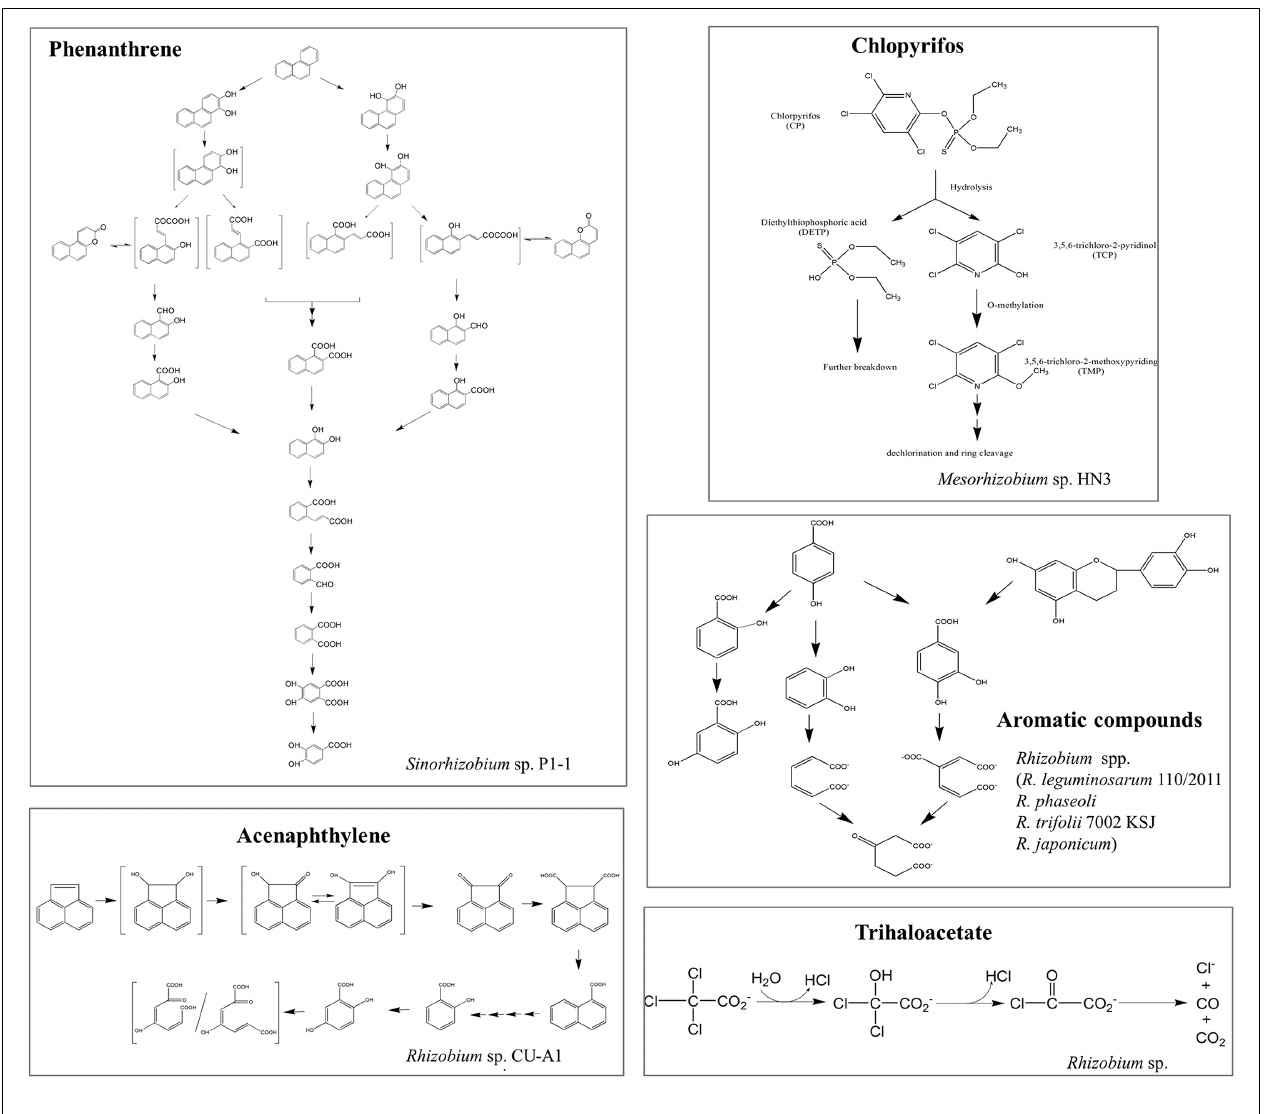
FIGURE 2 | Schematic representations of the proposed degradation pathways of several organic pollutants in rhizobial strains. Organic pollutants: phenanthrene (Keum etal., 2006), chlorpyrifos (Jabeen etal.,